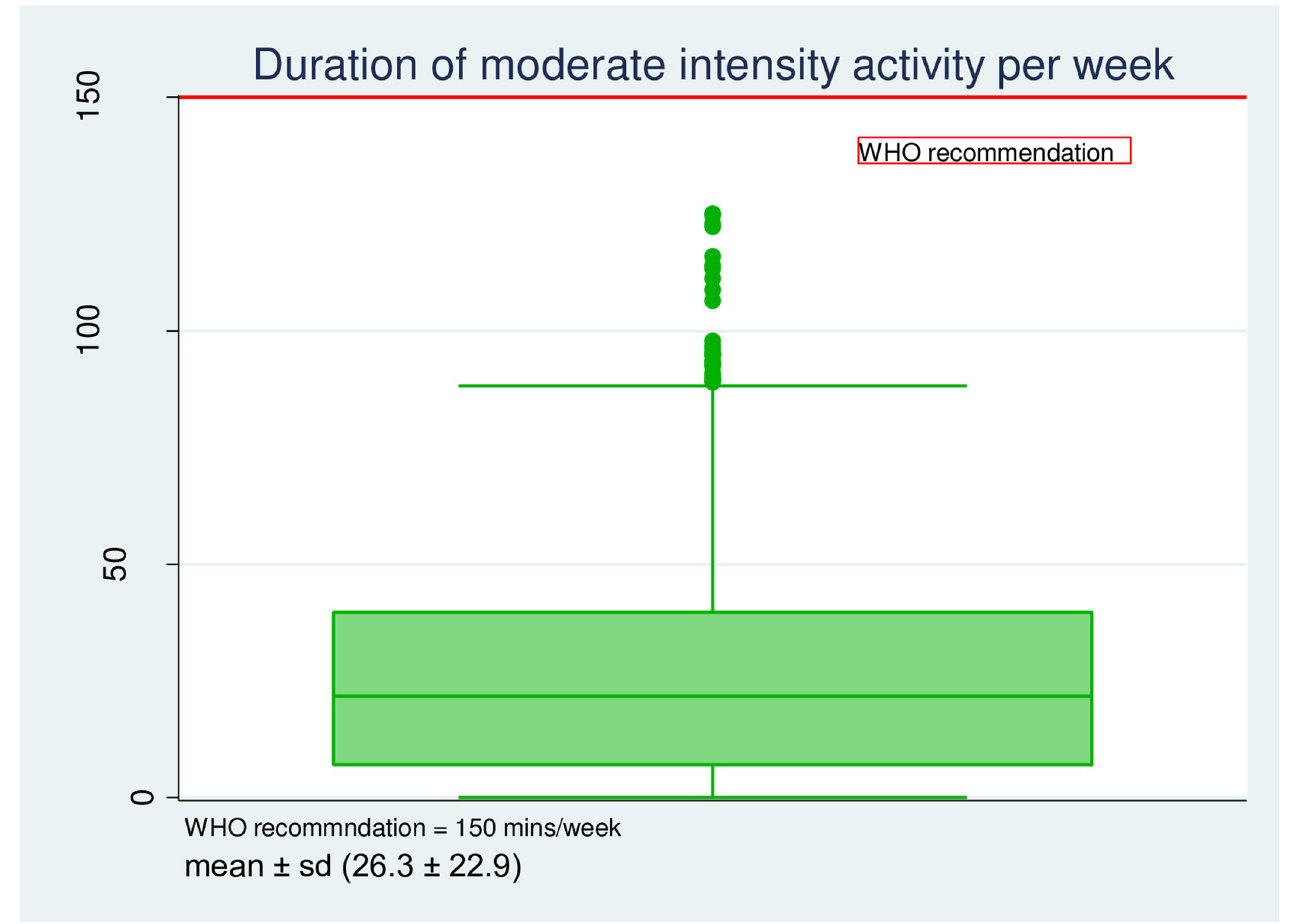
Fig 2. Duration of moderate intensity activity among the pregnant women in Ibadan,